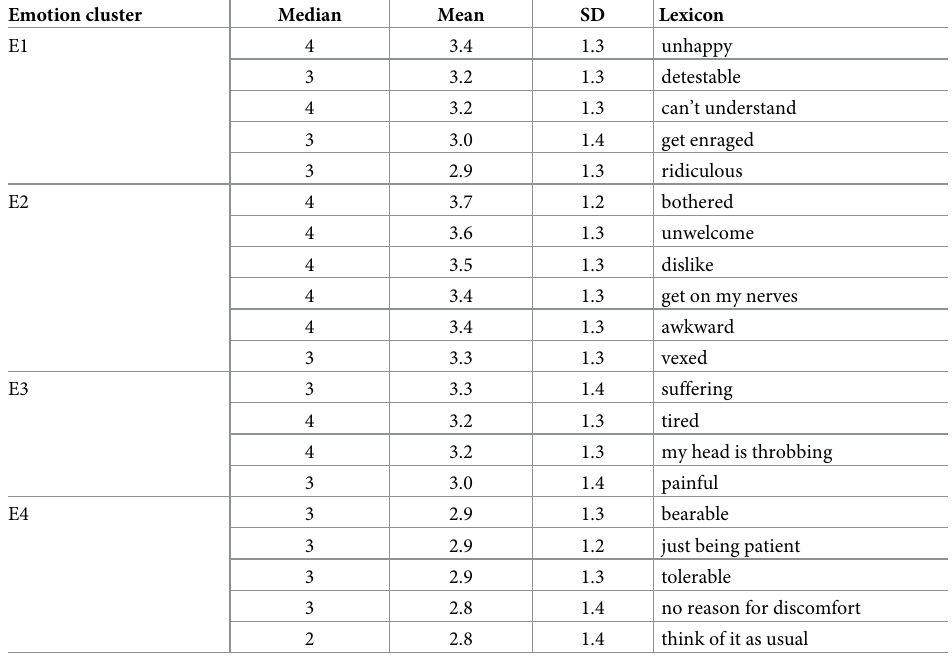
Table 5. Twenty lexicons used in the laboratory study. Korean lexicons used in the study can be found from one of supporting materials (S1 Table). Emotion